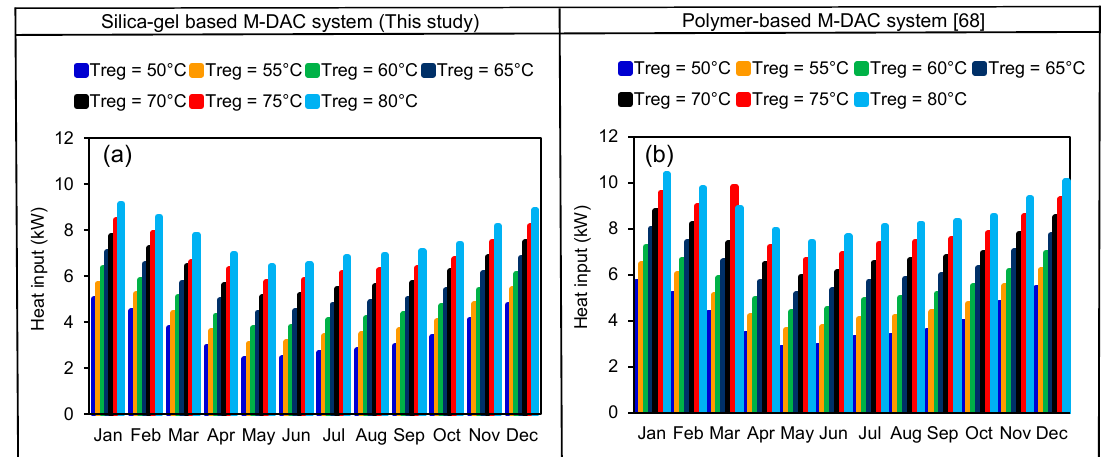
Figure A3. Heat input required for ( a ) silica-gel-based DAC system and ( b ) polymer-based DAC system at different regeneration temperatures.